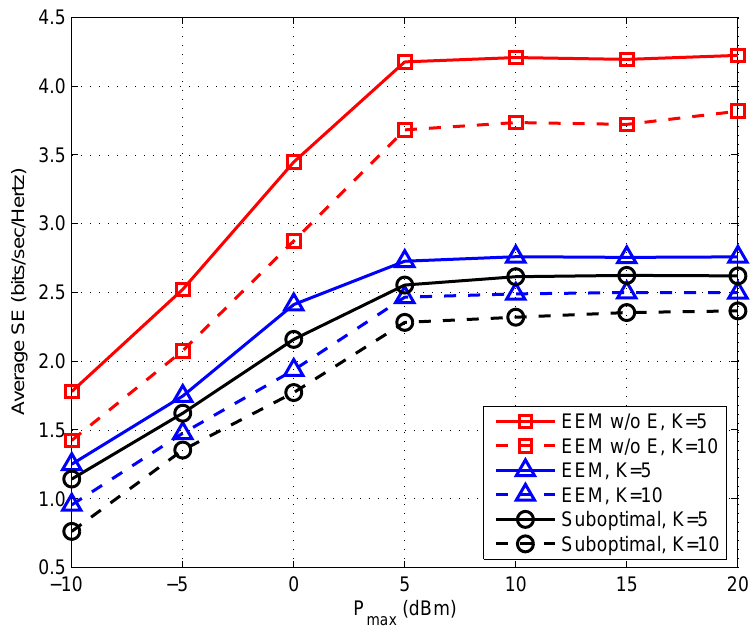
Figure 4. Average spectrum efficiency (SE) versus different P max